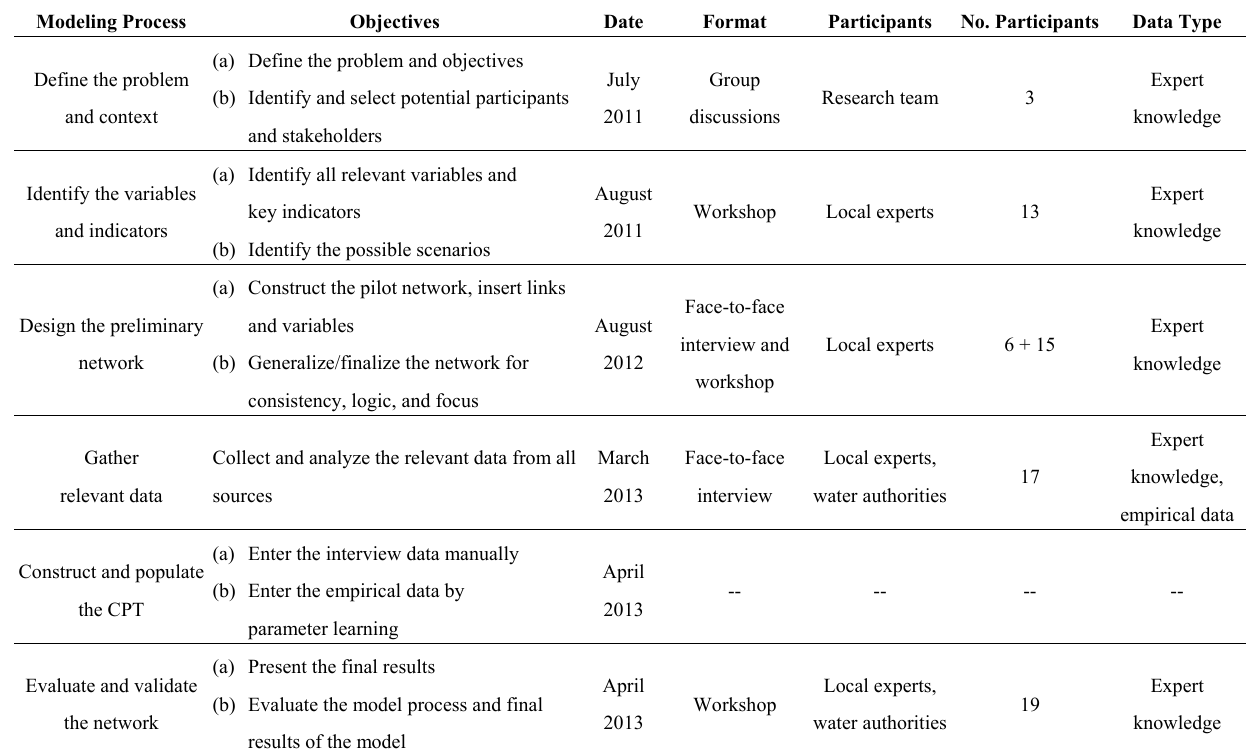
Table 1. Bayesian network modeling process to evaluate the impacts of water pricing on water use